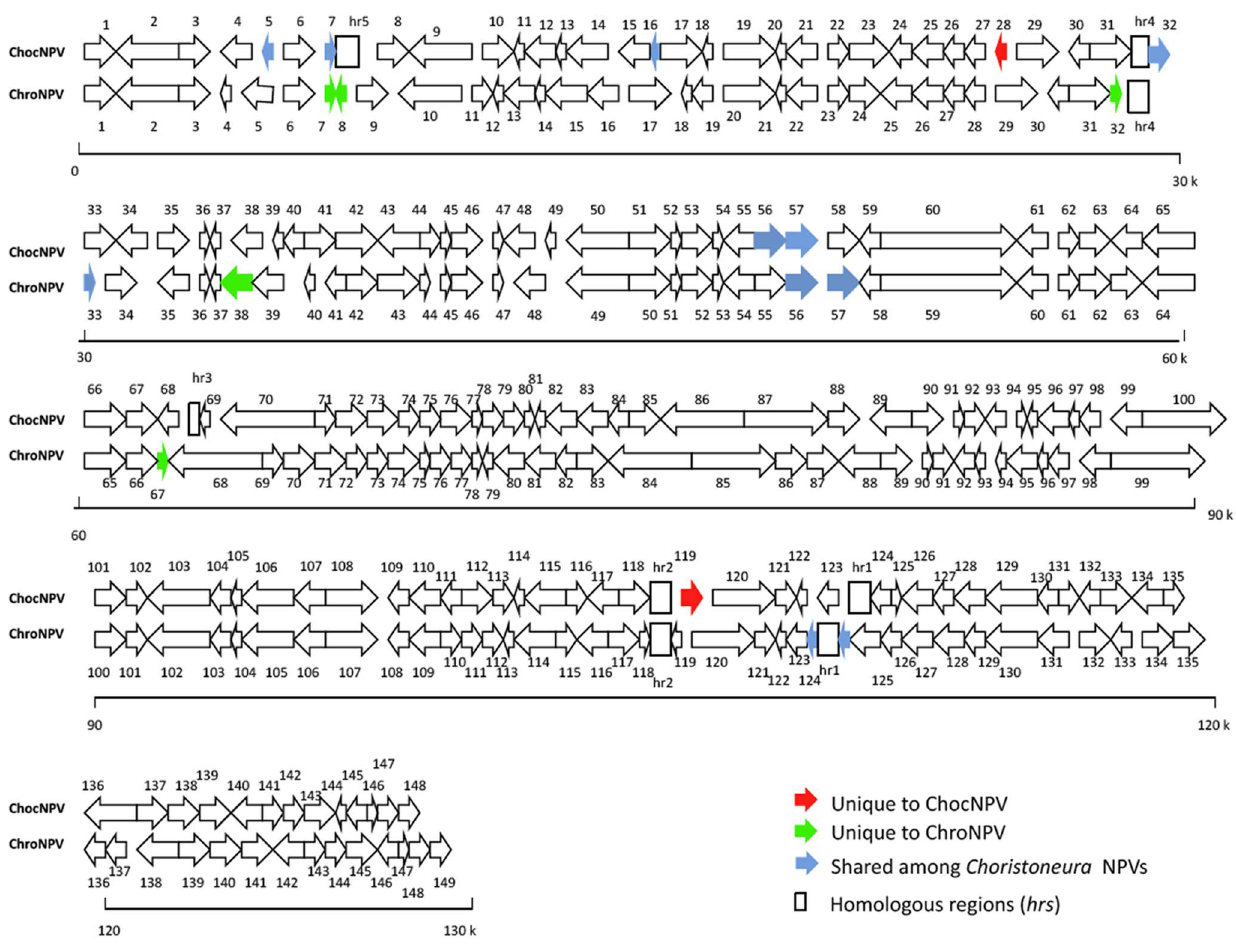
Figure 1. Linear representation of ChocNPV and ChroNPV genomes. The arrows depict the respective 148 and 149 putative ORFs and their relative positions in ChroNPV and ChocNPV genomes. ORFs unique to ChocNPV and ChroNPV genomes are indicated in red and green arrows, respectively. Blue arrows represent shared ORFs, whereas open boxes represent the relative positions of homologous regions ( hrs ) in the two genomes.